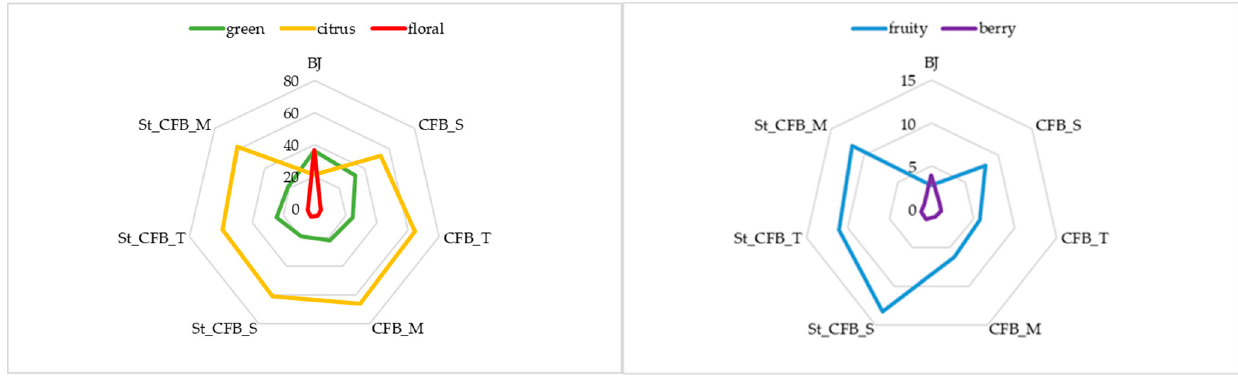
Figure 1. Amount of volatiles of specific flavor profiles of blackberry juice and blackberry cream fillings with the addition of sucrose, maltose and trehalose after preparation and after storage for three months (CFB—citrus fiber-blackberry cream fillings; S—sucrose; M—maltose; T—trehalose; St—storage).